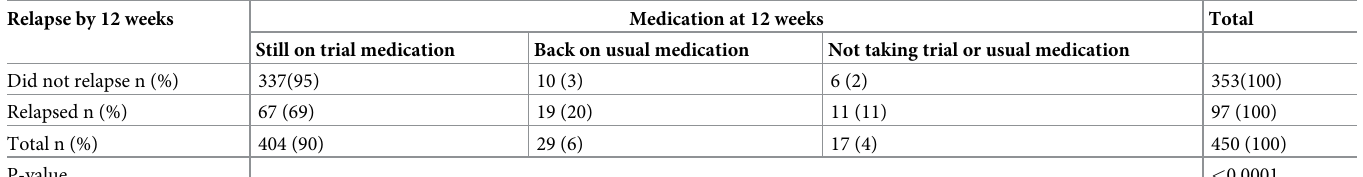
Table 5. Number of participants (%) who went back onto their usual antidepressants or stayed on trial medication or were not on any medication at 12 weeks when they relapsed. Relapse by 12 weeks